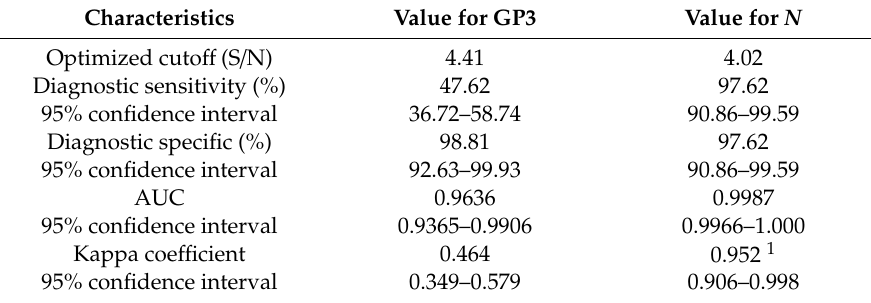
Figure 5. Measurement of antibody reactivities against GP3 and N with clinical serum samples. A set of 84 seronegative and 84 seropositive clinical serum samples were obtained from the Iowa State University Veterinary Diagnostic Laboratory. ( a ) The serological status of these samples was verified by using the IDEXX ELISA. Data are expressed as the sample to positive (S / P) ratios. The horizontal dotted line at S / P = 0.4 indicates the cuto ff of this assay. ( b ) The samples were tested by LIPS with GP3 and N protein as described in Materials and Method. Fetal bovine serum (FBS) was used as negative control. Data are expressed as sample to negative (S / N) ratios. The dotted lines indicate the cuto ff s of the respective assays. Table 4. ROC and kappa analysis for LIPS with field serum